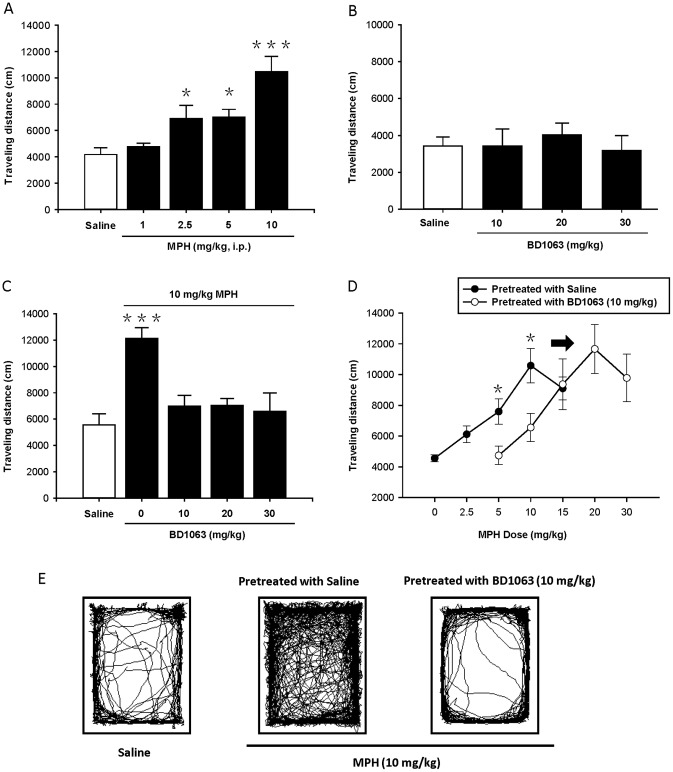
MPH induces locomotor hyperactivity via interaction with σ1 receptor.(A) Swiss Webster mice were injected (i.p.) with saline and MPH (1, 2.5, 5 and 10 mg/kg). 30 min later, MPH produced a significant stimulatory effect on locomotor activity in a dose-dependent manner. The horizontal activity was analyzed for 30 min in the open field. *P<0.05 and ***P<0.001 vs. saline, n = 7 for each group, post-hoc Dunnett’s tests. (B) BD1063 (10, 20 and 30 mg/kg) itself did not affect basal locomotion of the mice, compared with saline group. n = 7 for each group. No significance. (C) Pretreatment with BD1063 (10, 20, and 30 mg/kg) effectively blocked 10 mg/kg MPH-induced locomotor hyperactivity. n = 7 for saline, and n = 6 for other groups. ***P<0.001 vs. saline and other groups, post-hoc LSD multiple comparisons. (D) Pretreatment with BD1063 (10 mg/kg) shifted the MPH’s dose-response curves to the right. The mice in the left curve were pretreated with saline, then injected with MPH (0–15 mg/kg). Other group in the right curve was pretreated with BD 1063 (10 mg/kg), then injected with MPH (5–30 mg/kg). MPH with 5 mg/kg and 10 mg/kg groups, *P<0.05 in the absence of BD1063 vs. in the presence of BD1063, n = 7 for each group, post-hoc Student-Newman-Keuls. (E) Locomotor activity trace of MPH (10 mg/kg) stimulatory mice pretreated with saline (middle), were significantly different from saline control (left). Pretreated with 10 mg/kg BD1063 (right) effectively blocked MPH’s effect (middle).